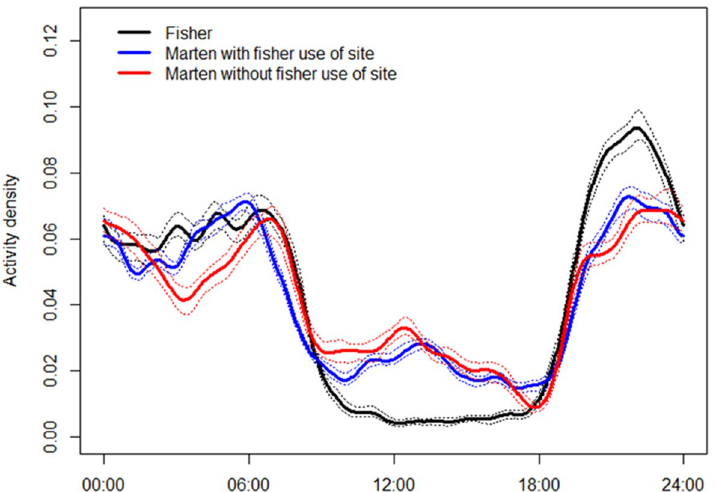
Figure 4. Circular kernel density estimates of diel activity with 95% confidence intervals (dotted lines) for fisher and American marten at sites with previous use by fisher or no previous use by fisher within the same winter, Upper Peninsula of Michigan, USA, January–March